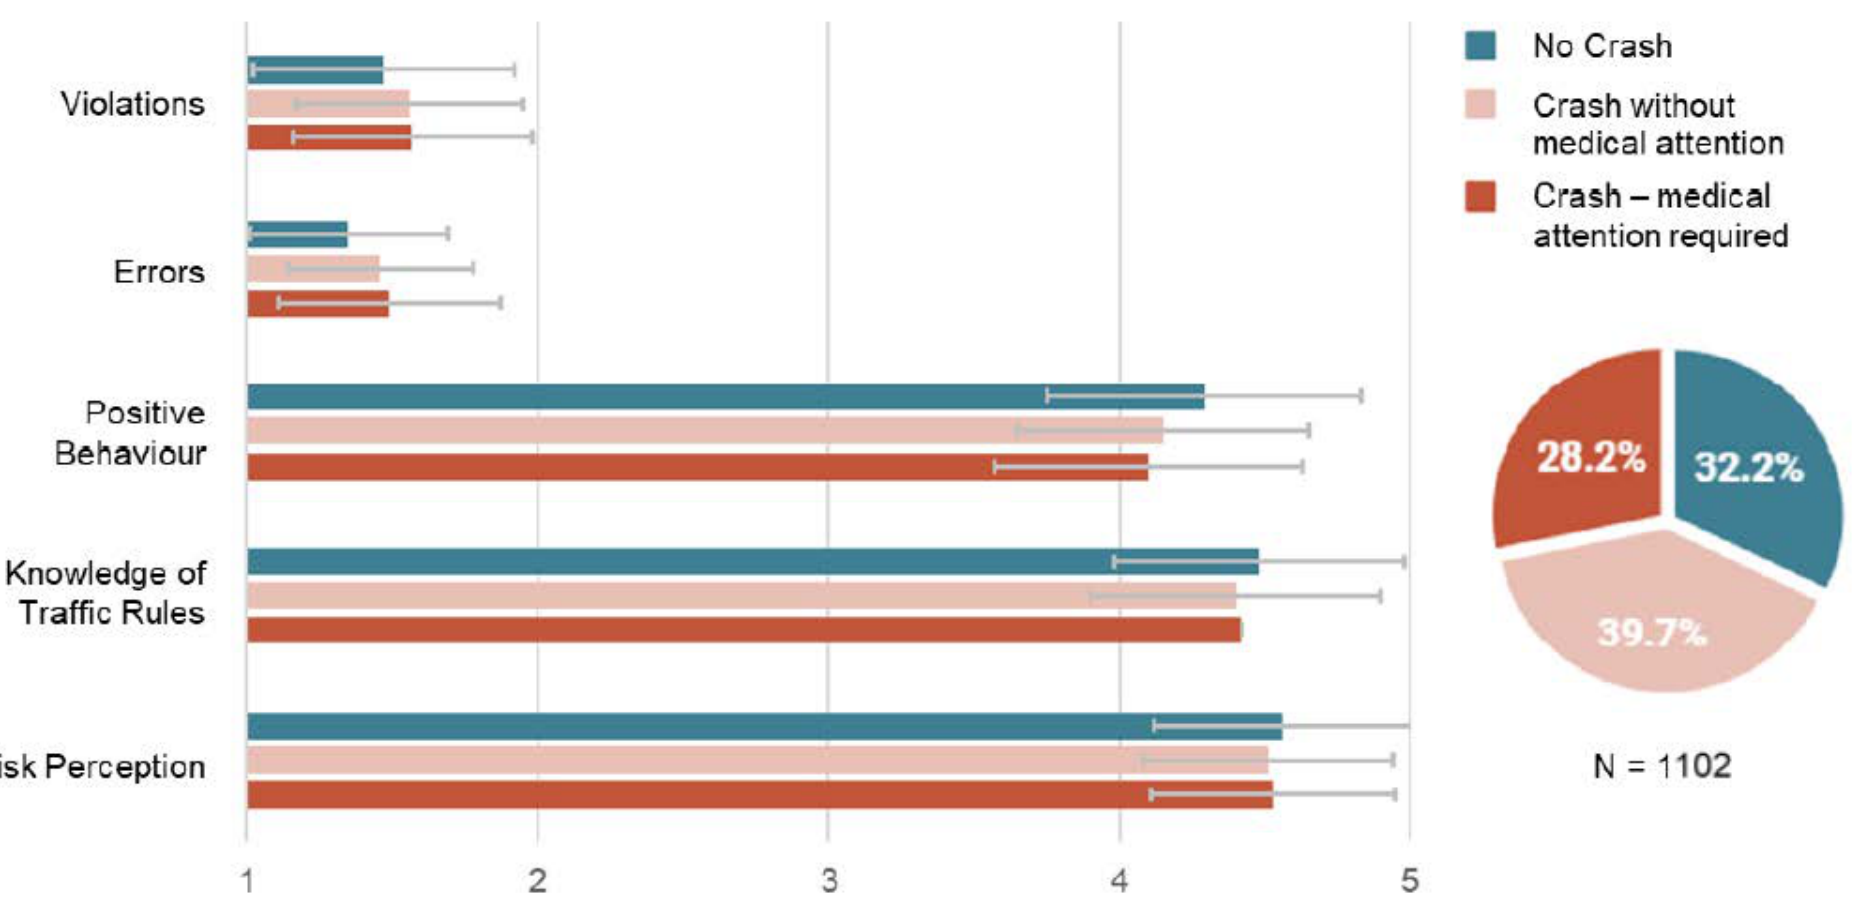
Figure 1. Summary of Cycling Behaviour Questionnaire (CBQ) and Risk Perception and Regulation Scale (RPRS) by crash